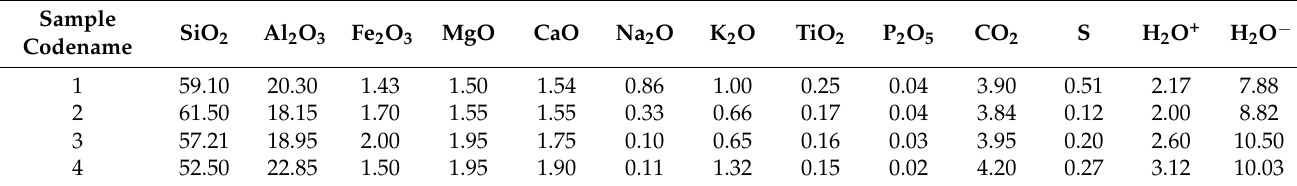
Table 6. Chemical composition of bentonite (1—bentonitized perlite; 2—bentonite; 3—bentonite fraction +0.01; 4—bentonite fraction − 0.01).